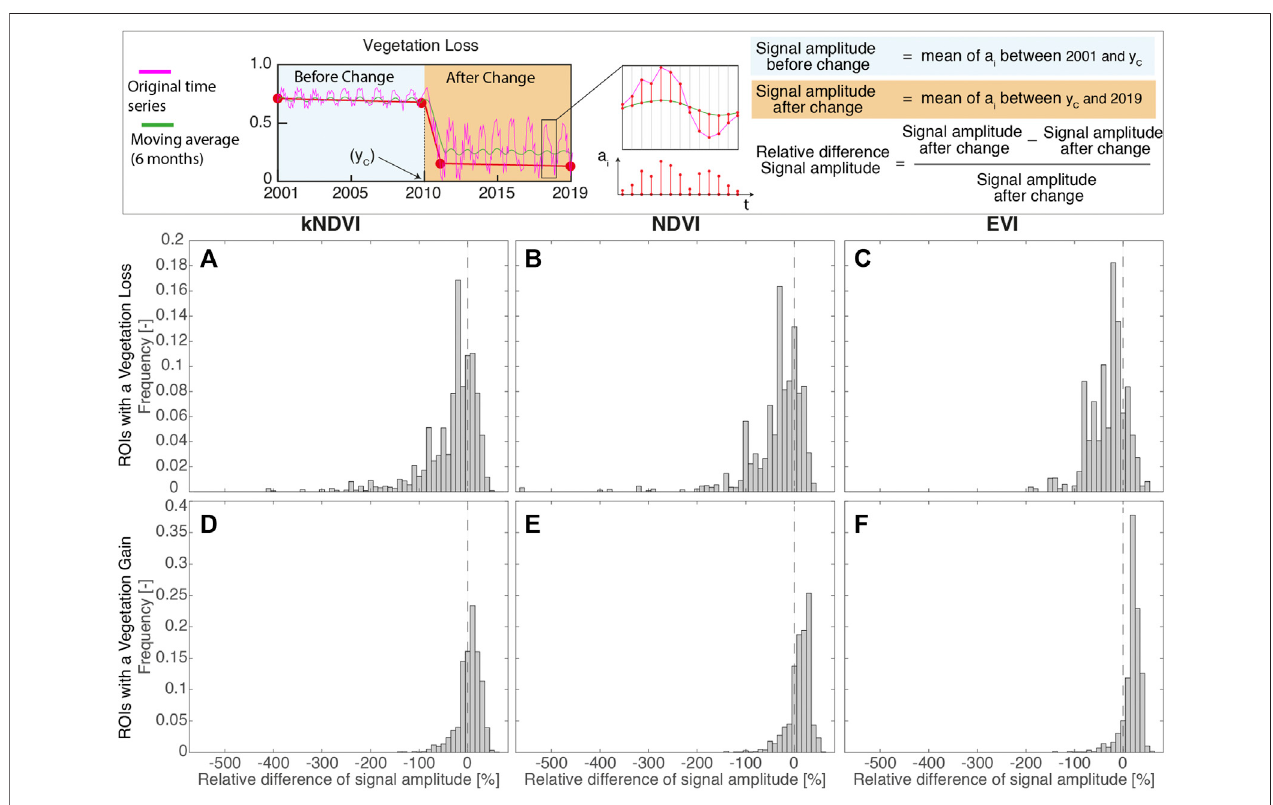
FIGURE 6 | Distribution of the (ROI-averaged) relative difference in the amplitude of intra-annual oscillation of the vegetation index, before and after the change within ROIs. The top panel explains how this quantity has been evaluated for a single pixel. (A) – (C) Forest loss (D) – (F) Forest gain.